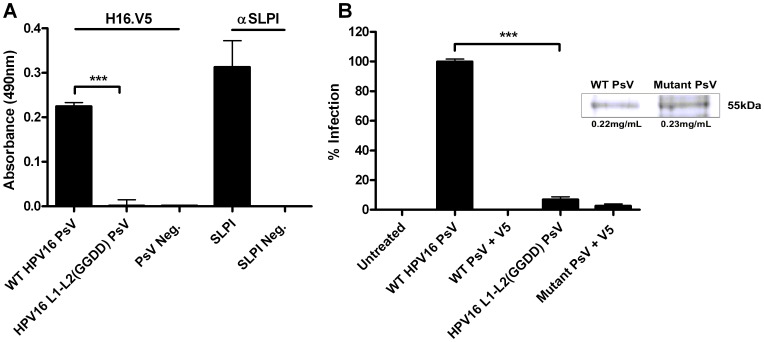
Mutations in HPV16 L2108–111 reduce PsV binding to A2t and PsV infectivity.(A) ELISA plate wells were coated with 500 ng of A2t prior to overnight incubation with 400 ng HPV16 PsV or HPV16 L1–L2(GGDD) mutant PsV and subsequently incubated with mouse anti-L1 H16.V5 or goat anti-SLPI antibodies. Anti-mouse and anti-goat HRP-conjugated secondary antibodies were added prior to the substrate. In control experiments, no ligands were used. The graph represents the mean absorbance measured at 490 nm ± SD (***P<0.001 as determined by a two-tailed, unpaired t-test between WT and mutant PsV). (B) HaCaT cells were infected with wild type (WT) or mutant (L2108–111 LVEE to GGDD) HPV16 pseudovirions containing a GFP plasmid. Infectivity was scored at 48 h post infection by enumerating GFP-positive cells by flow cytometry. The mean percentage of HPV16 PsV infected cells (GFP-positive) normalized to the WT PsV group ± SD are presented of two combined independent experiments. Inset shows the L1 band of a coomassie blue stained SDS-PAGE gel loaded with an equivalent amount of WT and mutant PsV used in the infectivity assays. (***P<0.001 as determined by a two-tailed, unpaired t-test between WT and mutant PsV group).